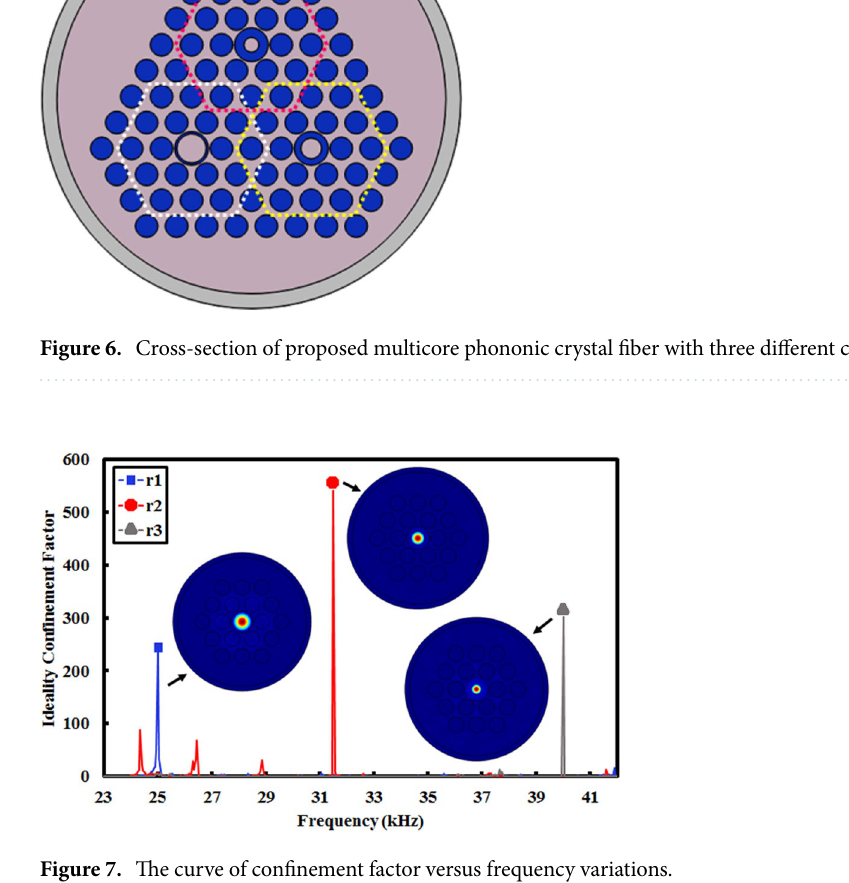
Figure 7. The curve of confinement factor versus frequency